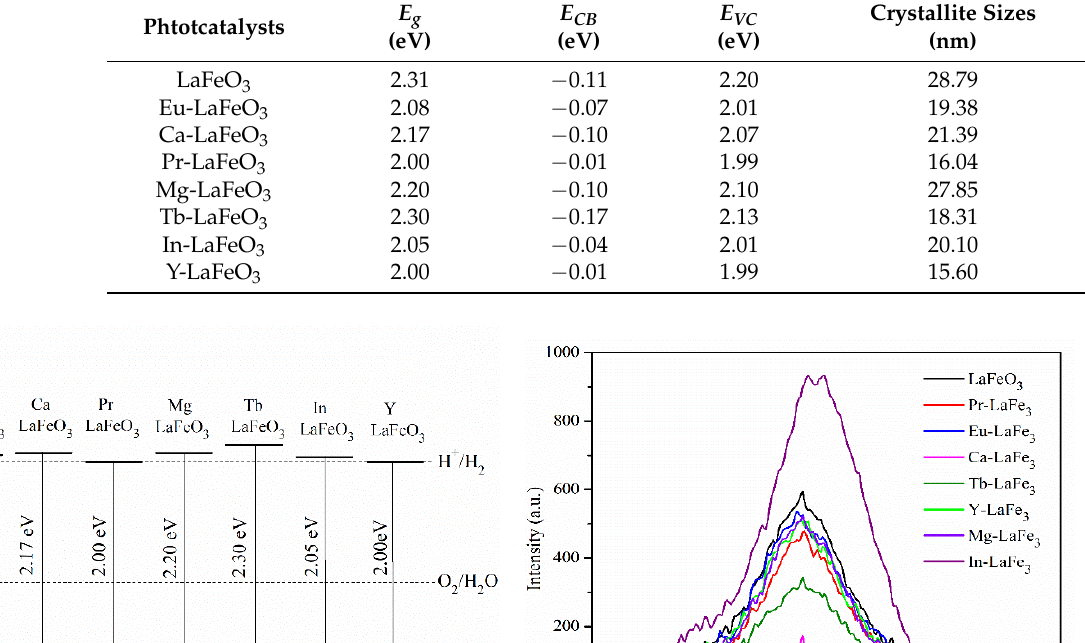
3 and undoped LaFeO 3